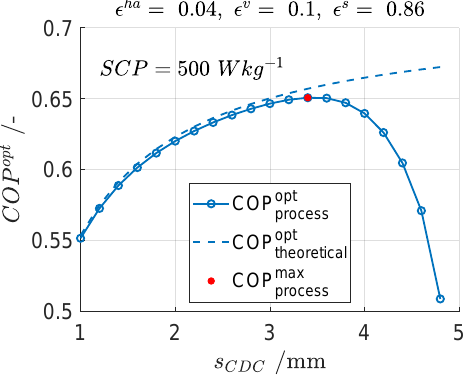
Figure 11. Maximum achievable COP max process in the two-dimensional parameter space concerning cycle time and CDC-plate layer thickness exemplary for a user desired SCP desired of 500